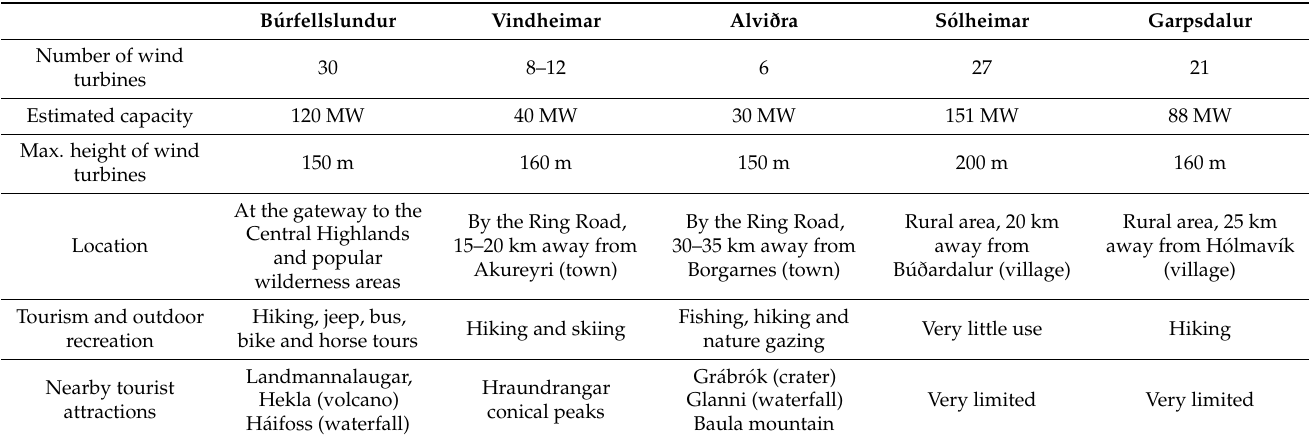
Figure 1. The five wind farms from the 4th phase of the Master Plan and their visibility. The proposed wind farm B ú rfellslundur is at the periphery of the southern Highlands and is the largest one with regard to the number of wind turbines (Table 1). It is located next to a road which functions as “the gateway” to the Central Highlands, an uninhabited natural area characterised by wilderness. This road leads to the most popular Highland destination called Landmannalaugar as well as many other Highland destinations. The pro- posed wind farm is furthermore close to the most developed power production area in the country, which includes six hydro power plants and their appendant infrastructure such as reservoirs and transmission lines. In addition, there are two experimental wind turbines which were set up there in 2012 to examine the practicality of wind energy utilisation in Iceland. Table 1. The characteristics and locations of the five proposed wind